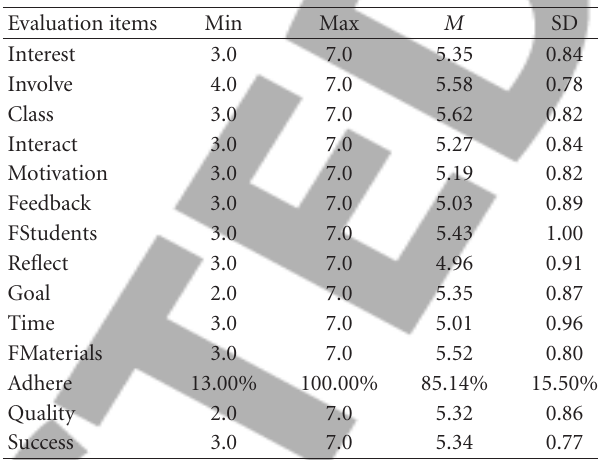
Table 2: Descriptive statistics of evaluation Items.